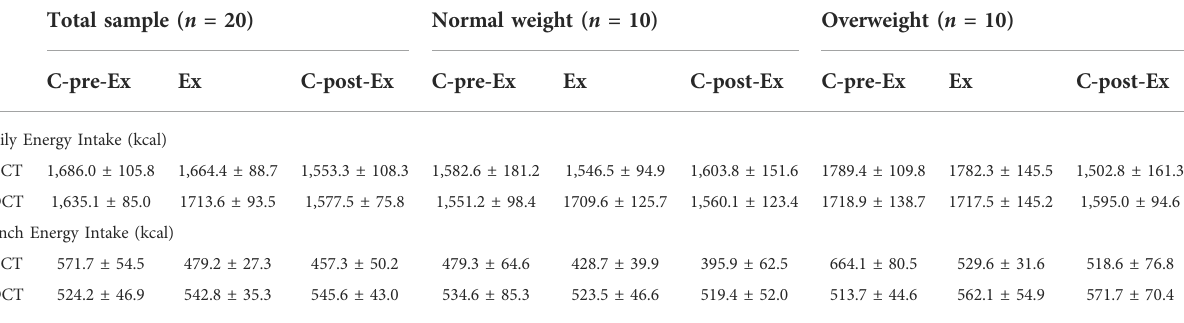
TABLE 2 Energy intake in the total sample, normal and overweight adults.